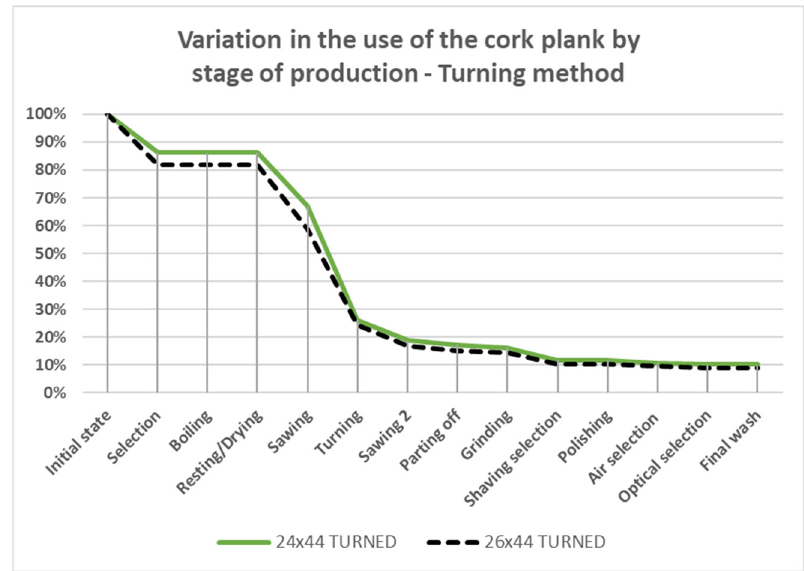
Figure 5. Variation in cork plank usage by production stage—turning method.